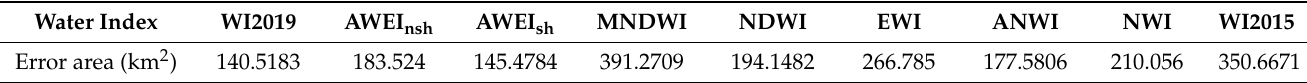
Table 3. Annual average extraction error area of each water index from 2000 to